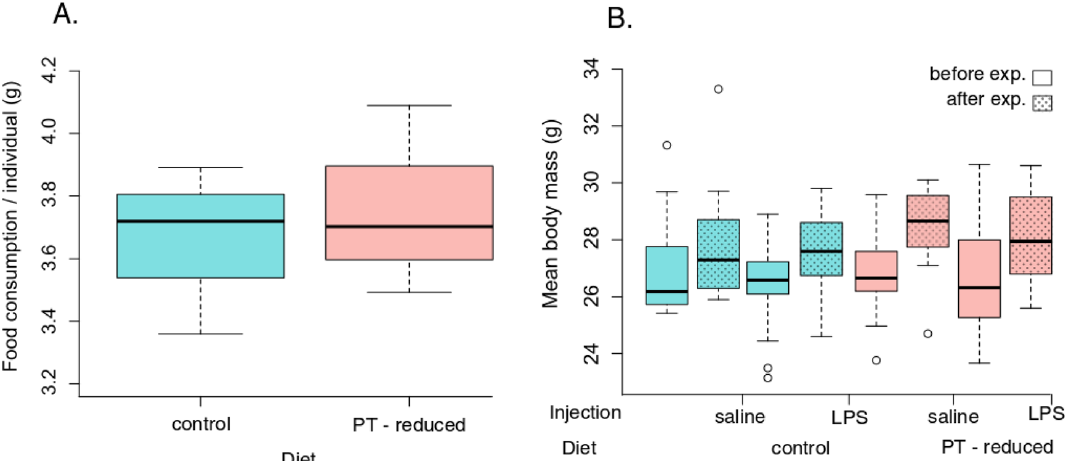
Figure 1. Food consumption and body mass of house sparrow. Food consumption (g) per individual in control and PT-reduced diet (phenylalanine and tyrosine at 42% of their level in the control diet; A ), body mass of house sparrows before and after the experiment ( B ). Control males were injected with saline vehicle, whereas immune challenged (LPS) birds were injected with lipopolysaccharide.